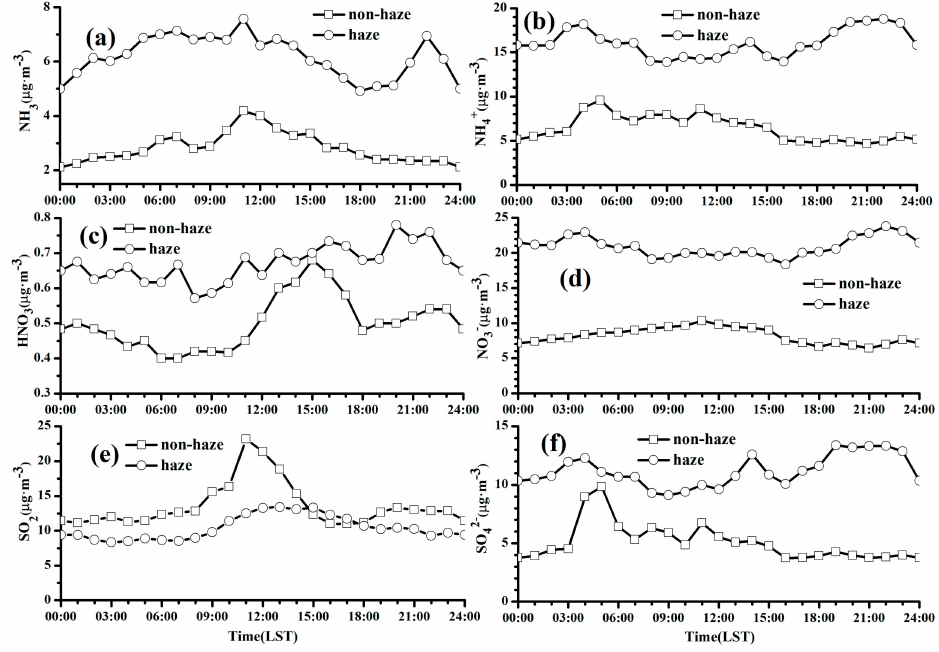
Figure 6. Diurnal variations of NH 3 ( a ), NH 4 + ( b ), HNO 3 ( c ), NO 3 − ( d ), SO 2 ( e ), and SO 42 − ( f